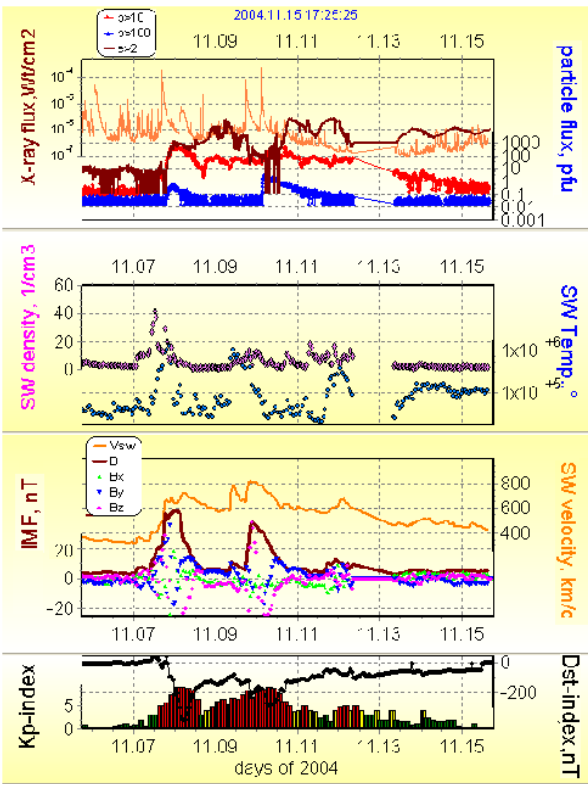
Fig. 7. Behavior of the different space weather parameters mea- sured by the satellite systems and ground level detectors during the solar activity burst in January 2005 (from real-time